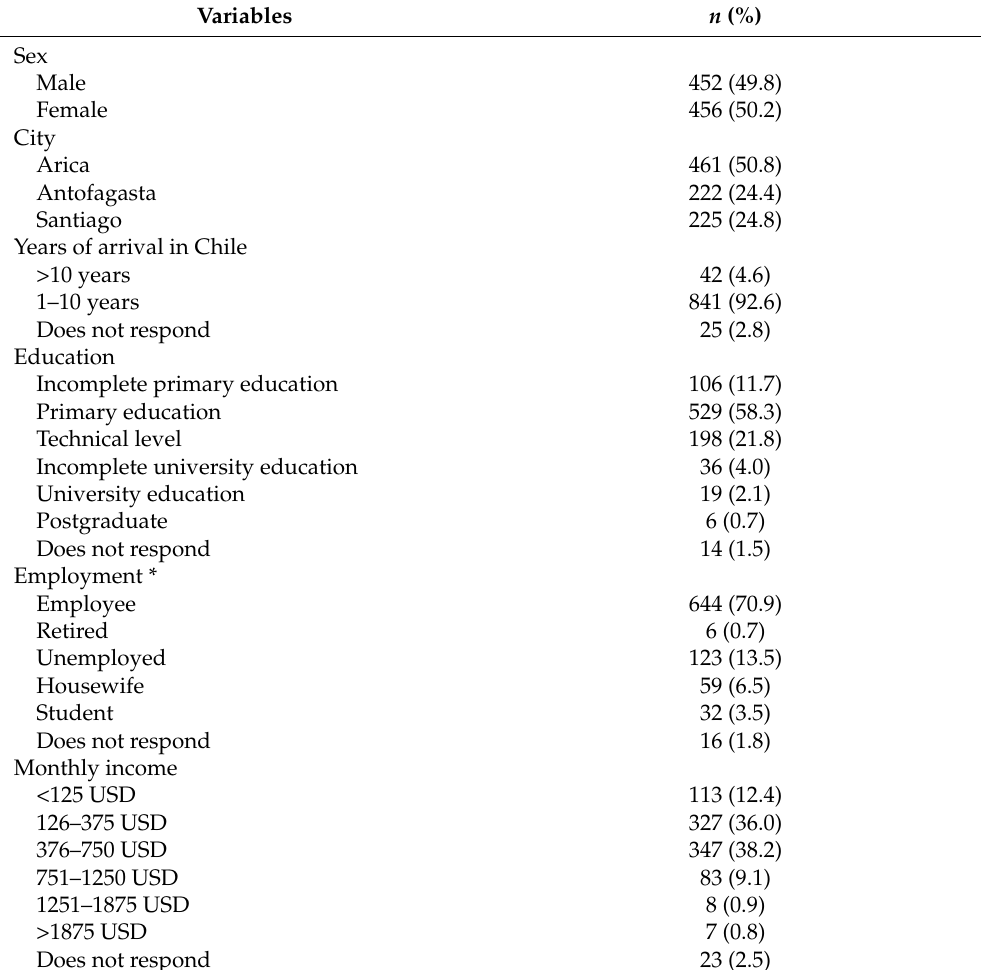
Table A1. Sociodemographic characteristics of